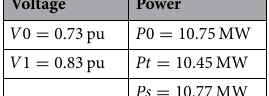
Table 18. Voltage and power values in the selected points of the